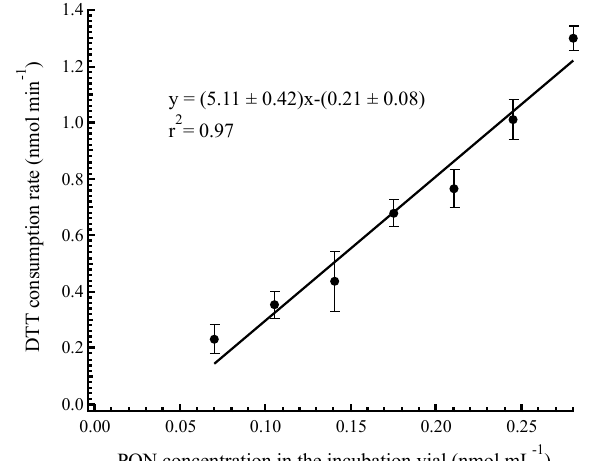
Figure 3. Blank-corrected DTT consumption rate as a function of PQN showing linearity between PQN concentrations and DTT con- sumption rate for the total analytical system (for PQN levels shown in the range above). Error bar represents the standard deviation of three independent DTT measurements on each concentration.